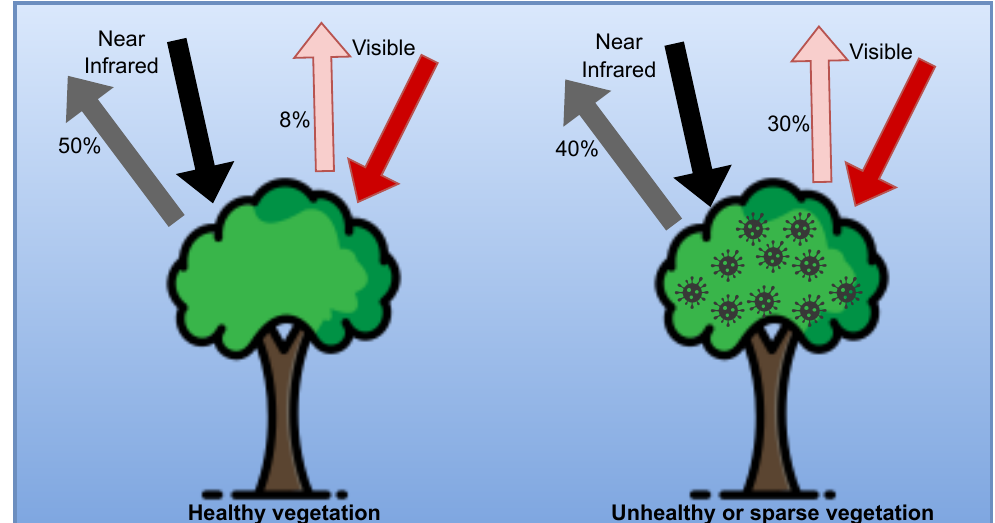
Figure 2. Absorbed and reflected radiation for plant’s health estimation (adapted from